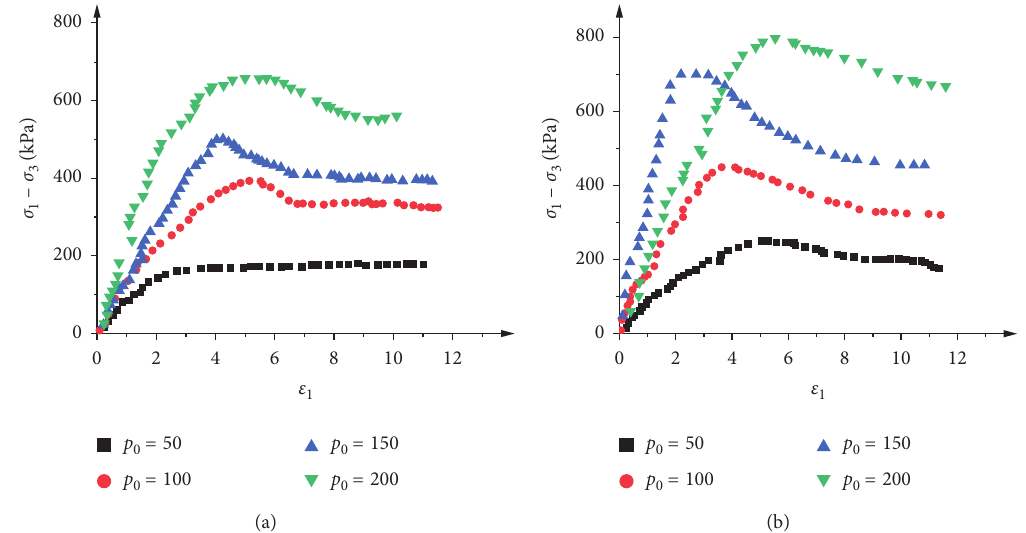
Figure 3: σ 1 – σ 3 ∼ ε 1 curve of the soil and stone mixture triaxial test: (a) b